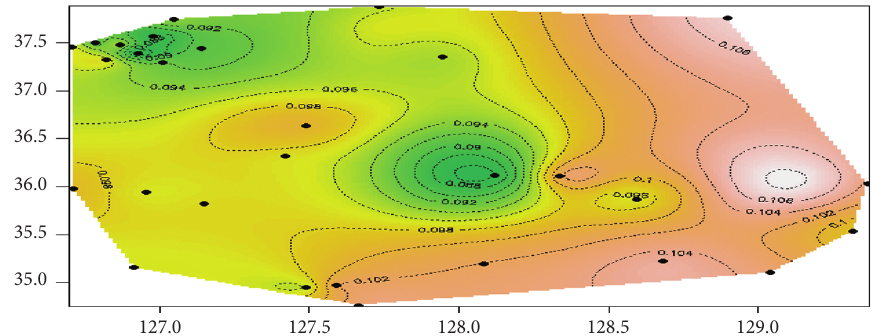
Figure 9: Interpolations of the 50 years’ return levels for extreme ozone concentrations in 29 air monitoring sites versus longitude ( x -axis) and latitude ( y -axis) in South Korea.